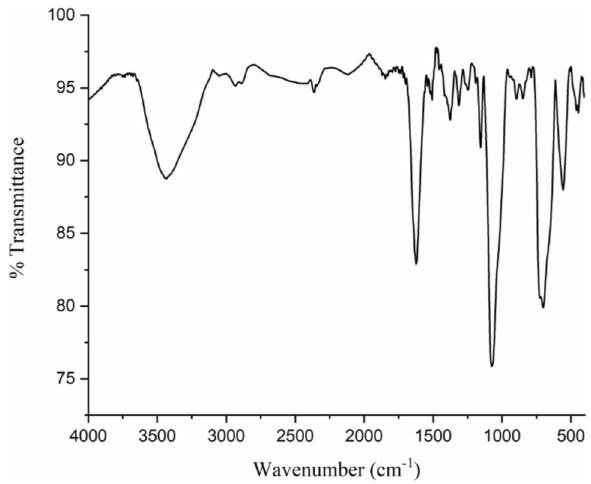
Figure 7. FT-IR spectrum of MCS@PhTet@Cu(II).